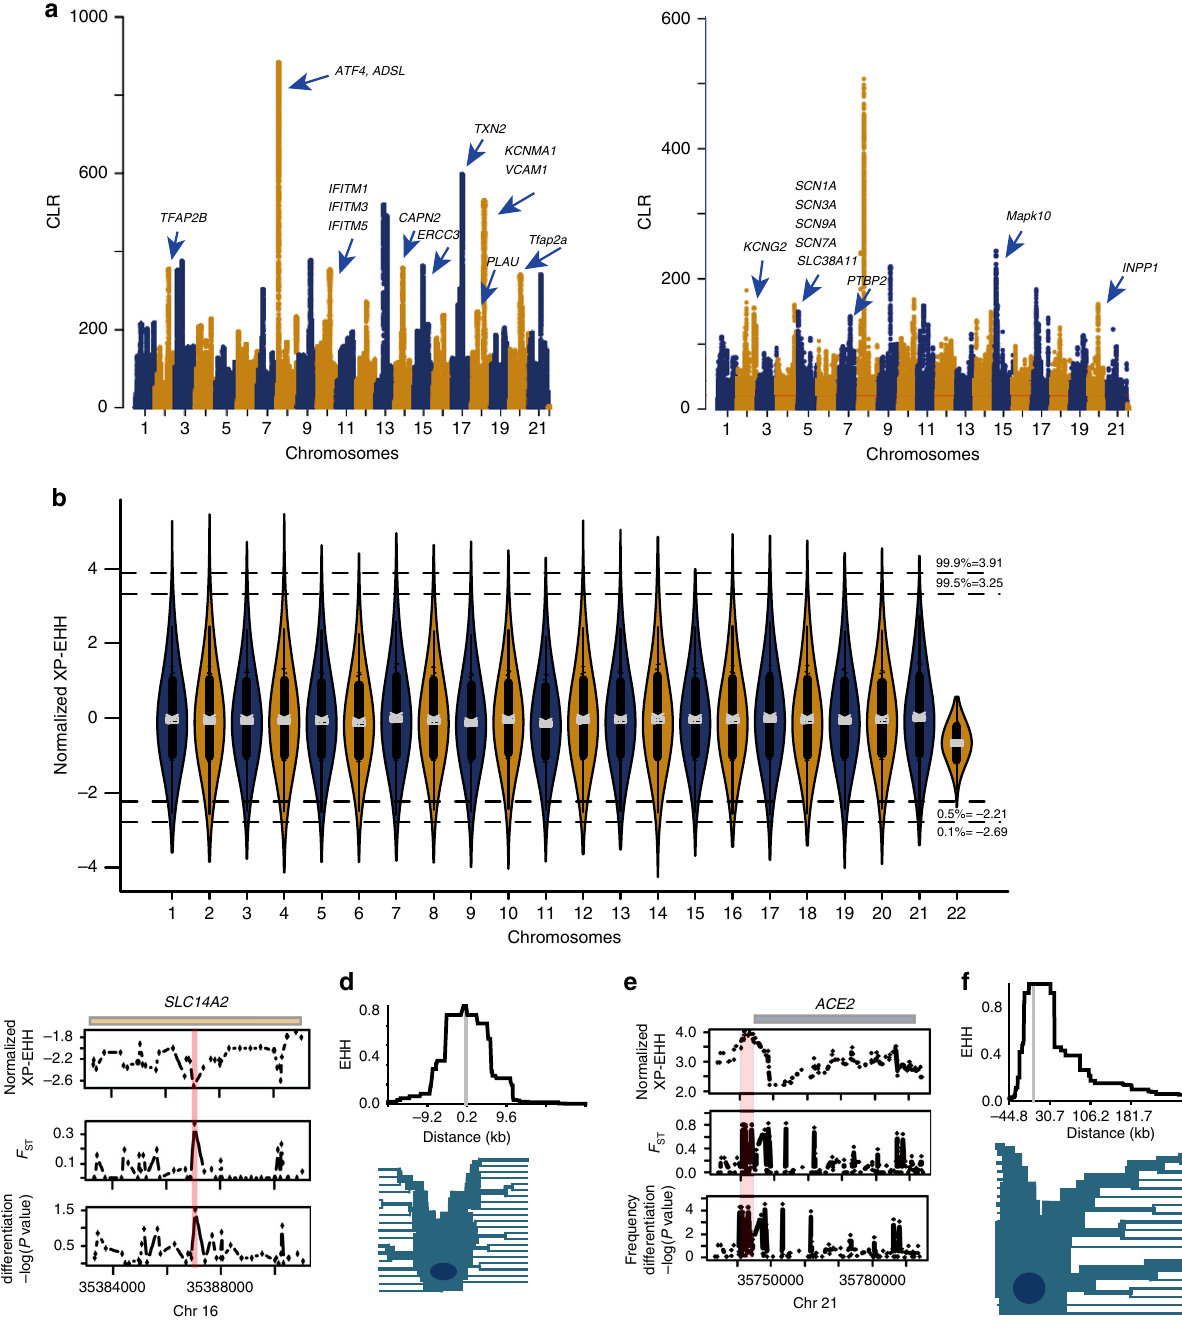
Fig. 3 Identi fi cation of selective sweeps in fi nless porpoise genomes. a Selective sweep regions identi fi ed in the narrow-ridged and wide-ridged fi nless porpoises. Plot of composite likelihood ratio (CLR) values that estimated in the wide-ridge (left panel) and narrow-ridge (right panel) fi nless porpoises. Genes residing within the selected regions that functioned in neuronal processes and response to biotic stimulus are presented for each peak according to their locations. b Violin plots of normalized XP-EHH values were generated by comparing the Yangtze River population and their marine relatives (Yellow Sea population) (the medians are shown). c Normalized XP-EHH values, population differentiations ( F ST ), and frequency differences of the selected region near gene SLC14A2 . d The EHH at varying distances from the core region (upper panel) and Haplotype bifurcation diagrams (lower panel) for core haplotype at SLC14A2 . e Normalized XP-EHH values, population differences ( F ST ), and frequency differences of the selected region near gene ACE2 . f The EHH at varying distances from the core region (upper panel) and Haplotype bifurcation diagrams (lower panel) for core haplotype at